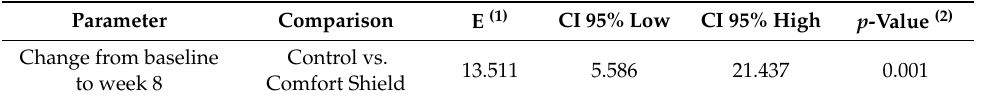
Table 8. OSDI: Multivariate analysis on change from baseline to week 8—mixed-e ff ects model for repeated measures—PPS population ( n = 84)— n used =